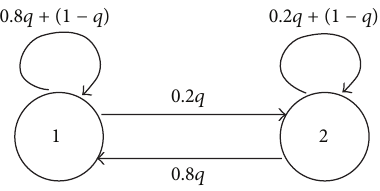
Figure 2: Discrete-time Markov chain in 𝑓 (3)